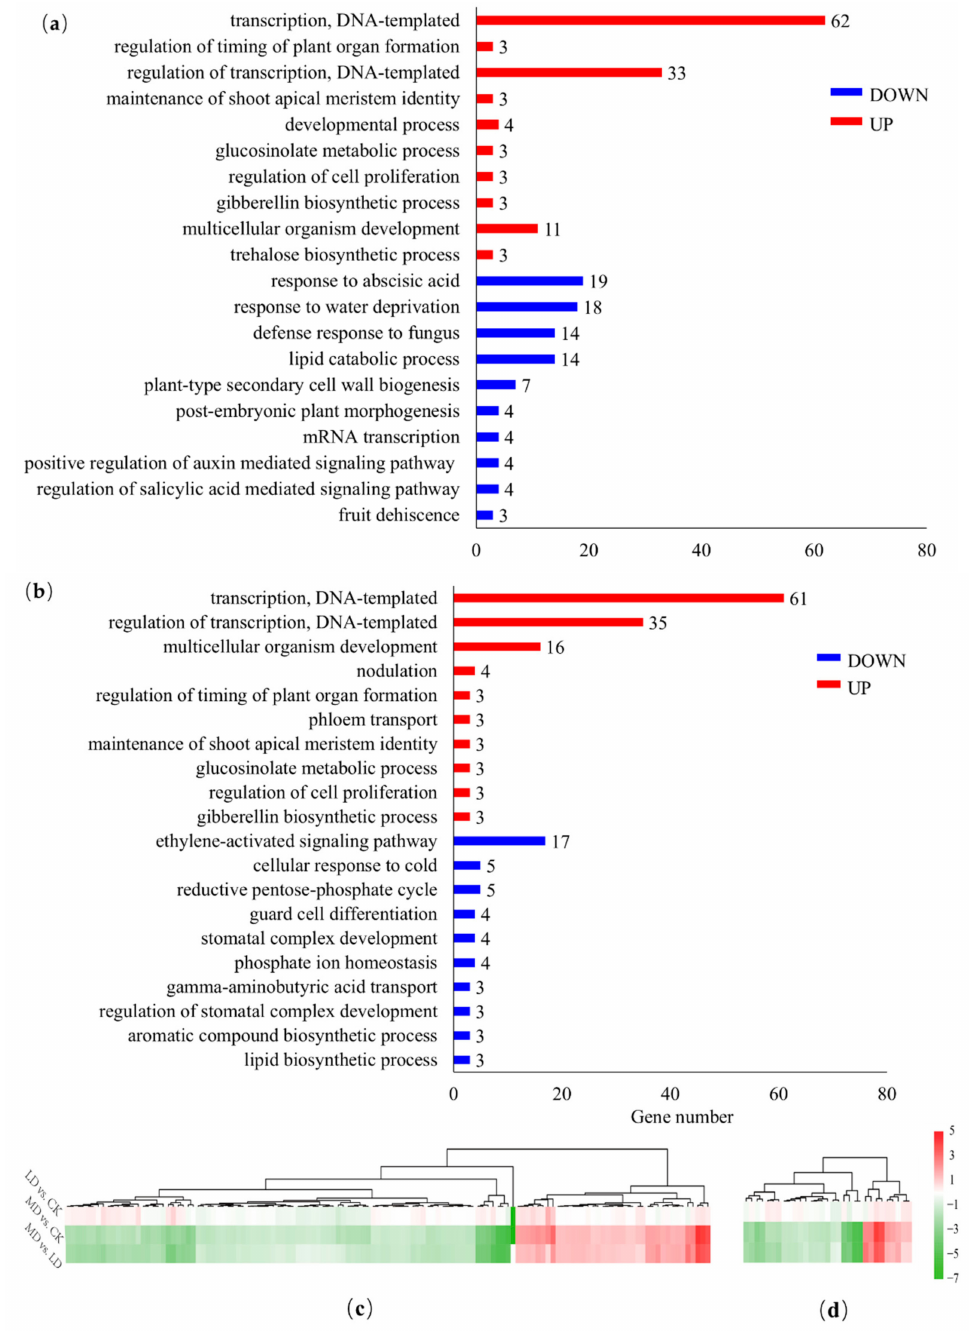
Figure 5. Top 20 biological processes enriched by the up-and down-regulated genes in the ( a ) MD vs. CK and ( b ) MD vs. LD comparisons. Expression pattern of the di ff erentially expressed genes associated with ( c ) development progress and ( d ) growth in the three comparisons. Colors indicate the log 2 fold change values. Red indicates up-regulation, and green indicates down-regulation in that